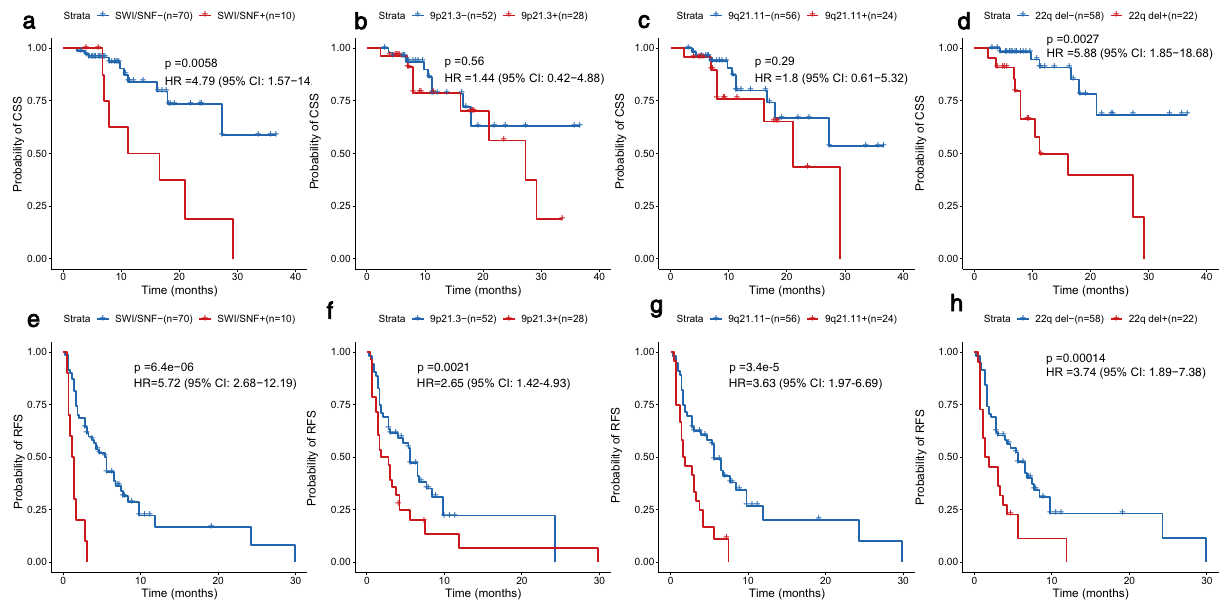
Fig. 5 Genomic features in relation to chordoma-speci fi c survival (CSS) and recurrence-free survival (RFS). CSS ( a – d ) and RFS ( e – h ) of chordoma patients strati fi ed by PBRM1 status, 9p21.3 deletion, 9q21.11 deletion, and 22q deletion. p values, hazard ratios (HRs), and 95% con fi dence intervals (CIs) were obtained from Cox proportional hazards models with the adjustment of age, sex, presurgery and post-surgery radiation therapy. “ + ” indicates subjects carrying the genomic alteration. See also Supplementary Table